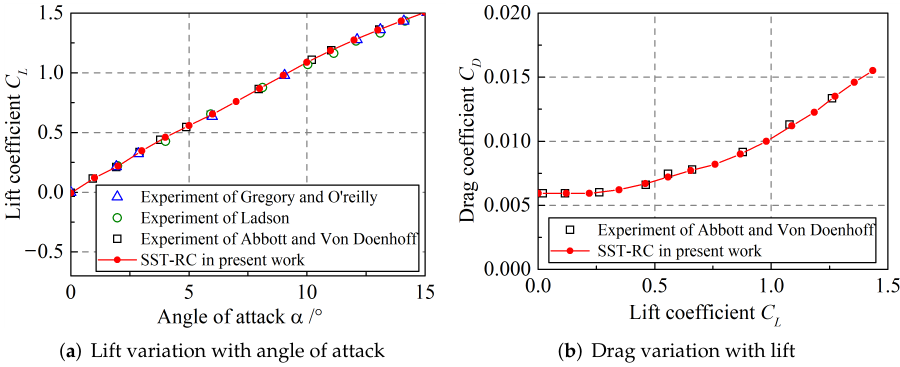
Figure 7. Comparison work of SST-RC model in the present code with previous work ([40–42]).